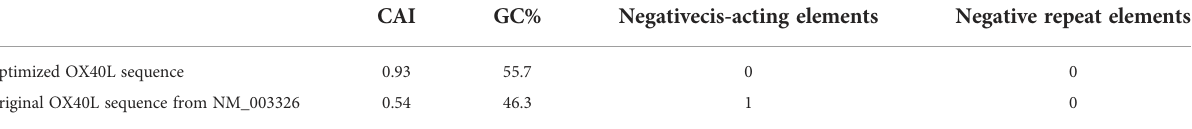
TABLE 1 Sequence optimization score of the optimized and original